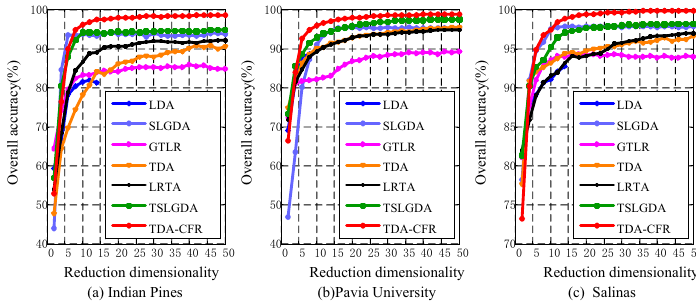
Figure 6. OA with SVM classifier versus the variation of reduced